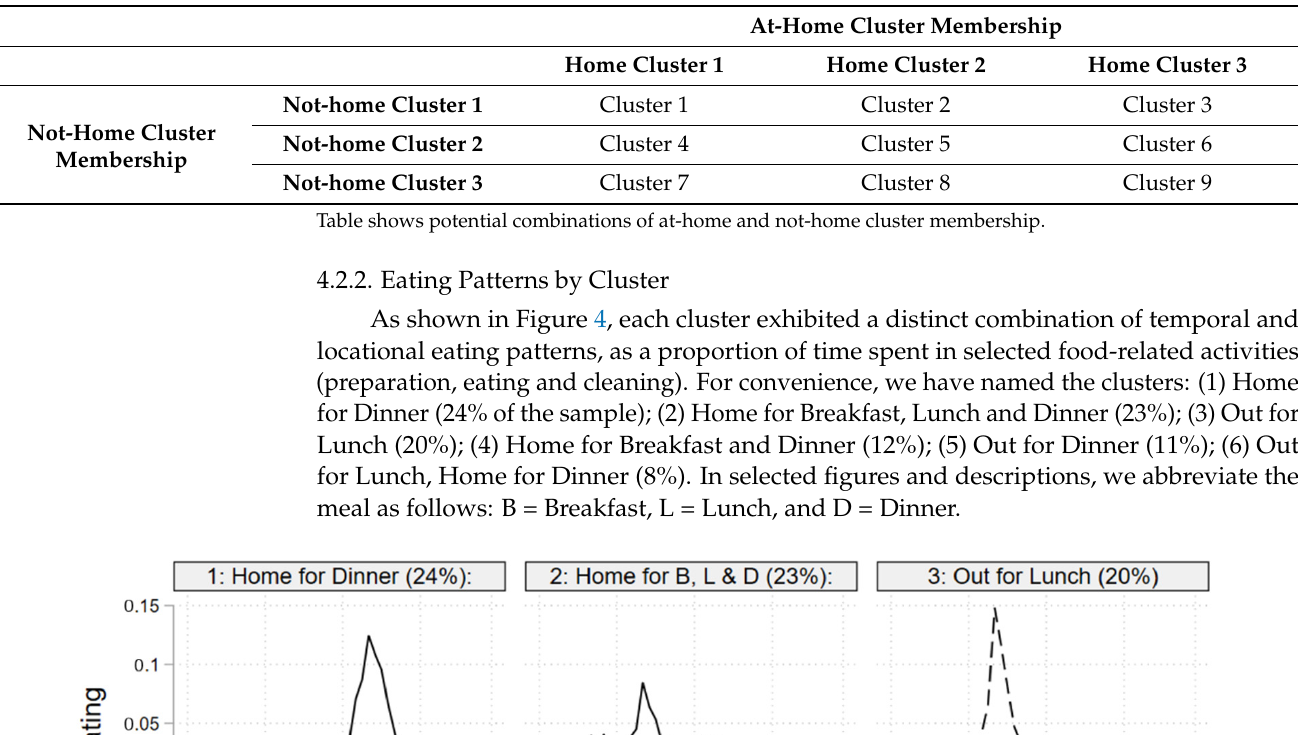
Table 2. Combinatorial Approach to Cluster Membership.